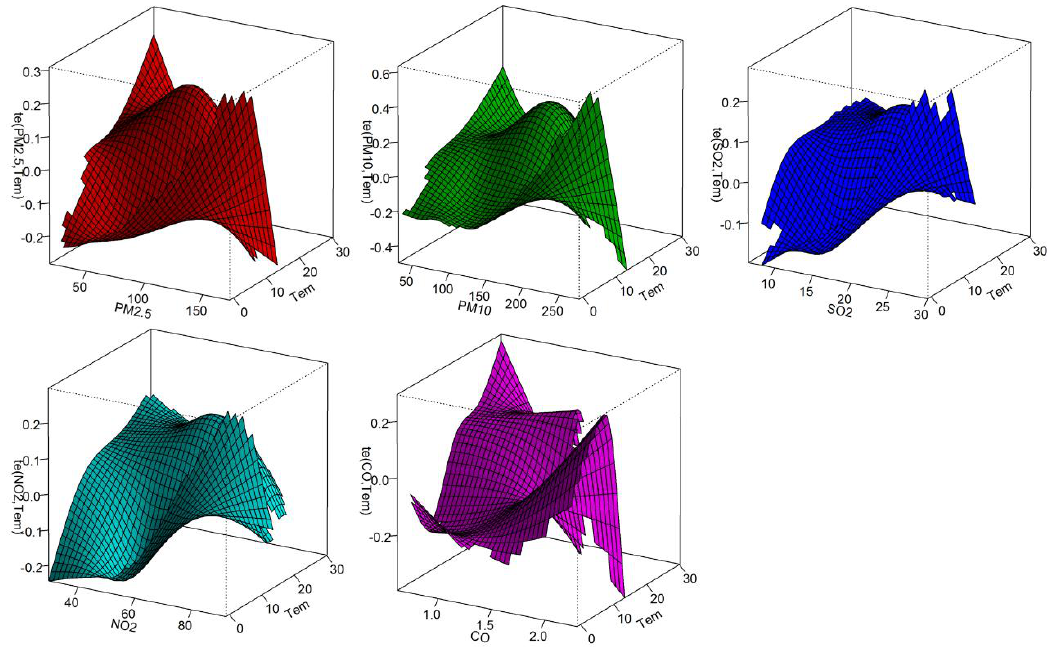
Figure 1. Interactive effects between air pollutants and temperature on COPD HAs.